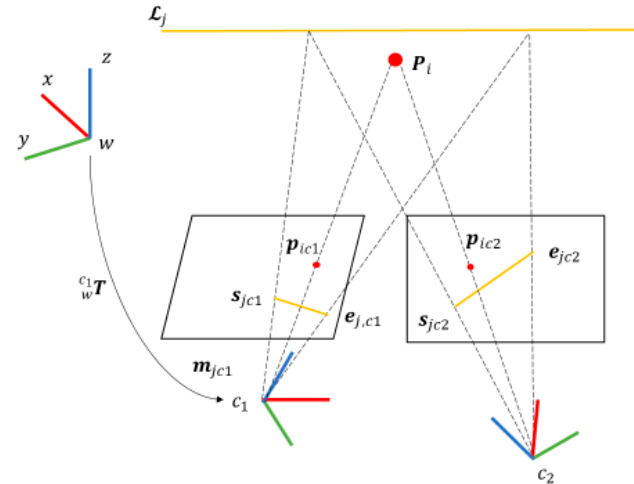
Figure 2. An illustration of the RGB-D camera and point and line measurements.